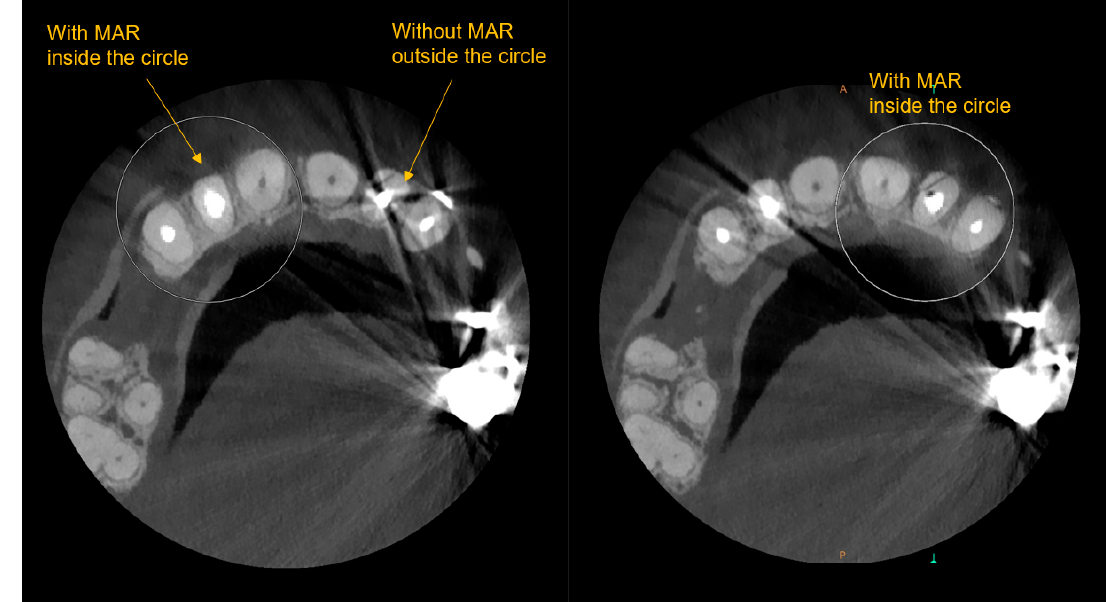
Figure 1. Axial views of CBCT with and without Metal artifact reduction (MAR) - (Carestream CS9600 MAR).